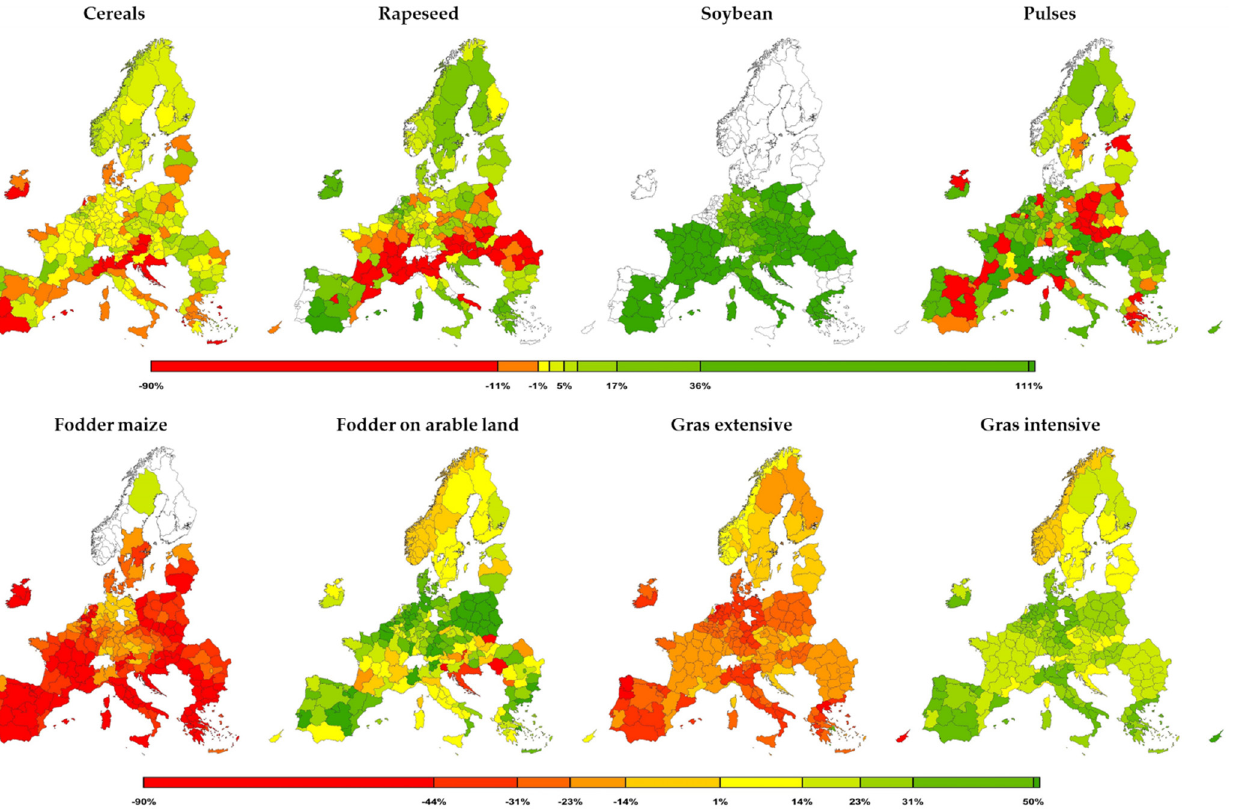
Figure 4. Land use change by cropping type in percentage change to the baseline.